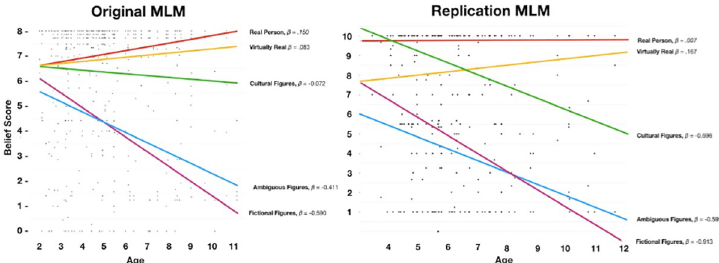
Fig 9. Results of the multilevel model in which a child’s age interacts with category of figure.